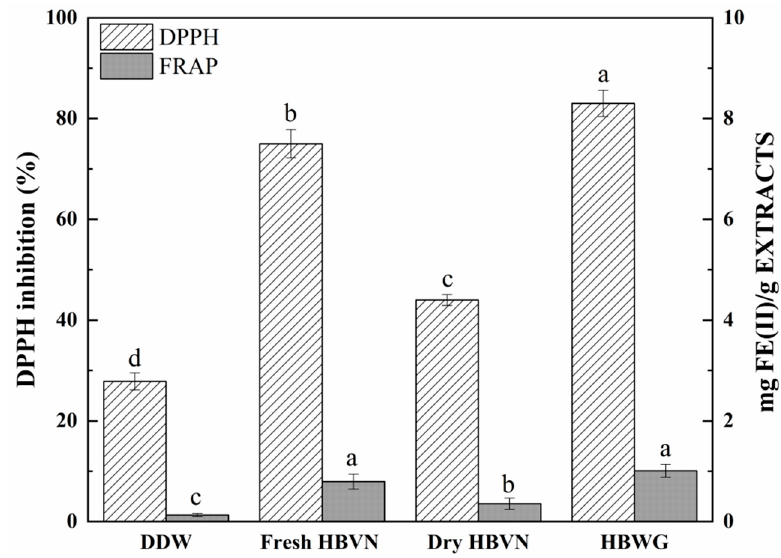
Figure 2. Evaluation of the antioxidant activity of HBWG and fresh and dry HBVN using the FRAP and DPPH methods. Error bars are standard deviations ( n = 3). Different letters above the columns represent significant difference at p < 0.05.